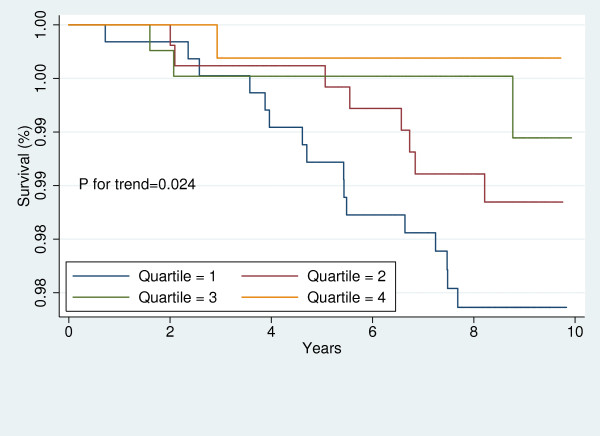
Kaplan-Meier curves for all-cause mortality across LAP quartiles in men with global CVD risk less than 20%.